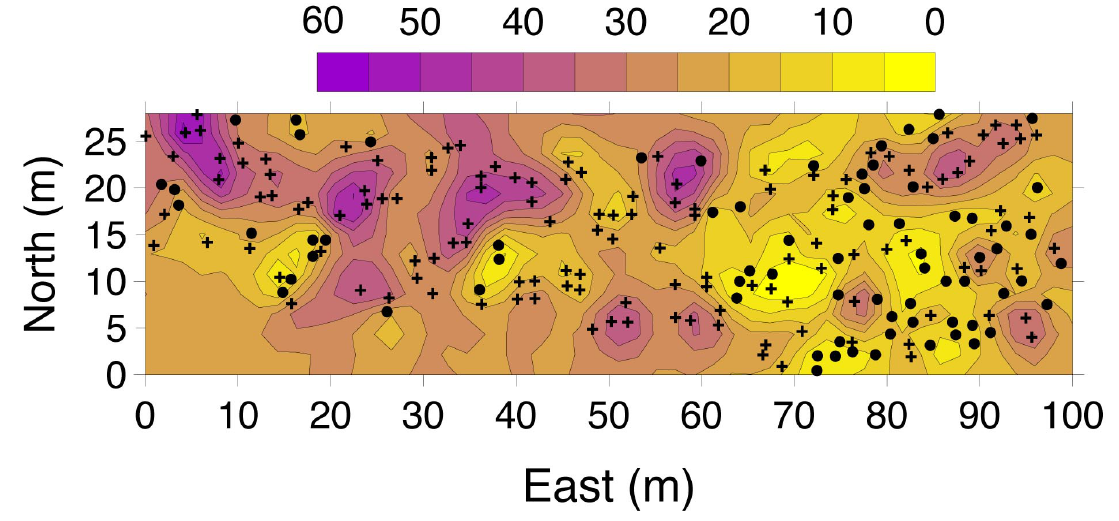
Fig. 7. Small-scale spatial distribution of the amount of bare soil covering planting holes (in %) and of seedling survival three years after planting. Crosses (+) and circles (•) are dead and alive seedlings, respectively. There is a significant negative relationship between the amount of bare soil and the survival of seedlings (logistic regression; p < 0.001). Elaborated from Maestre et al.